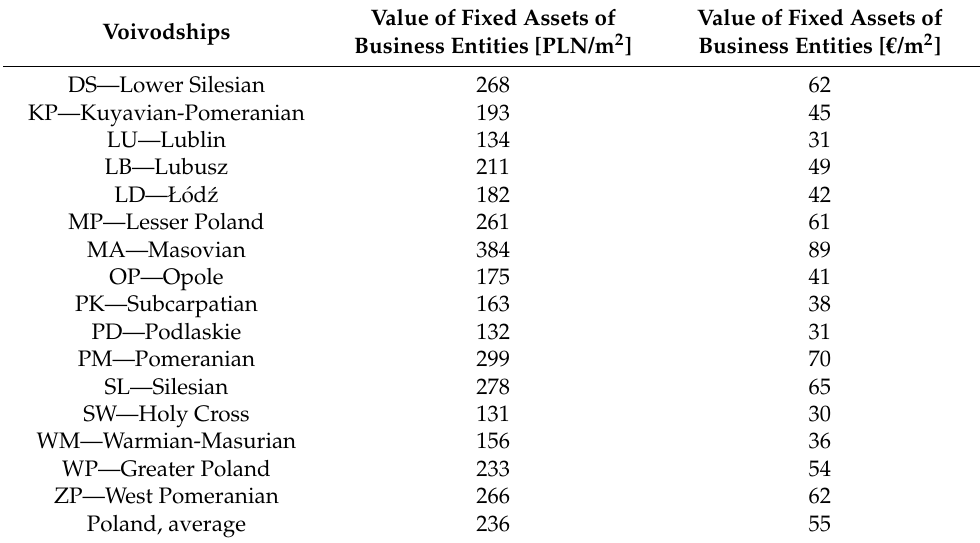
Table 3. Value of fixed assets of business entities in residential areas in 16 voivodships (in 2019 prices).